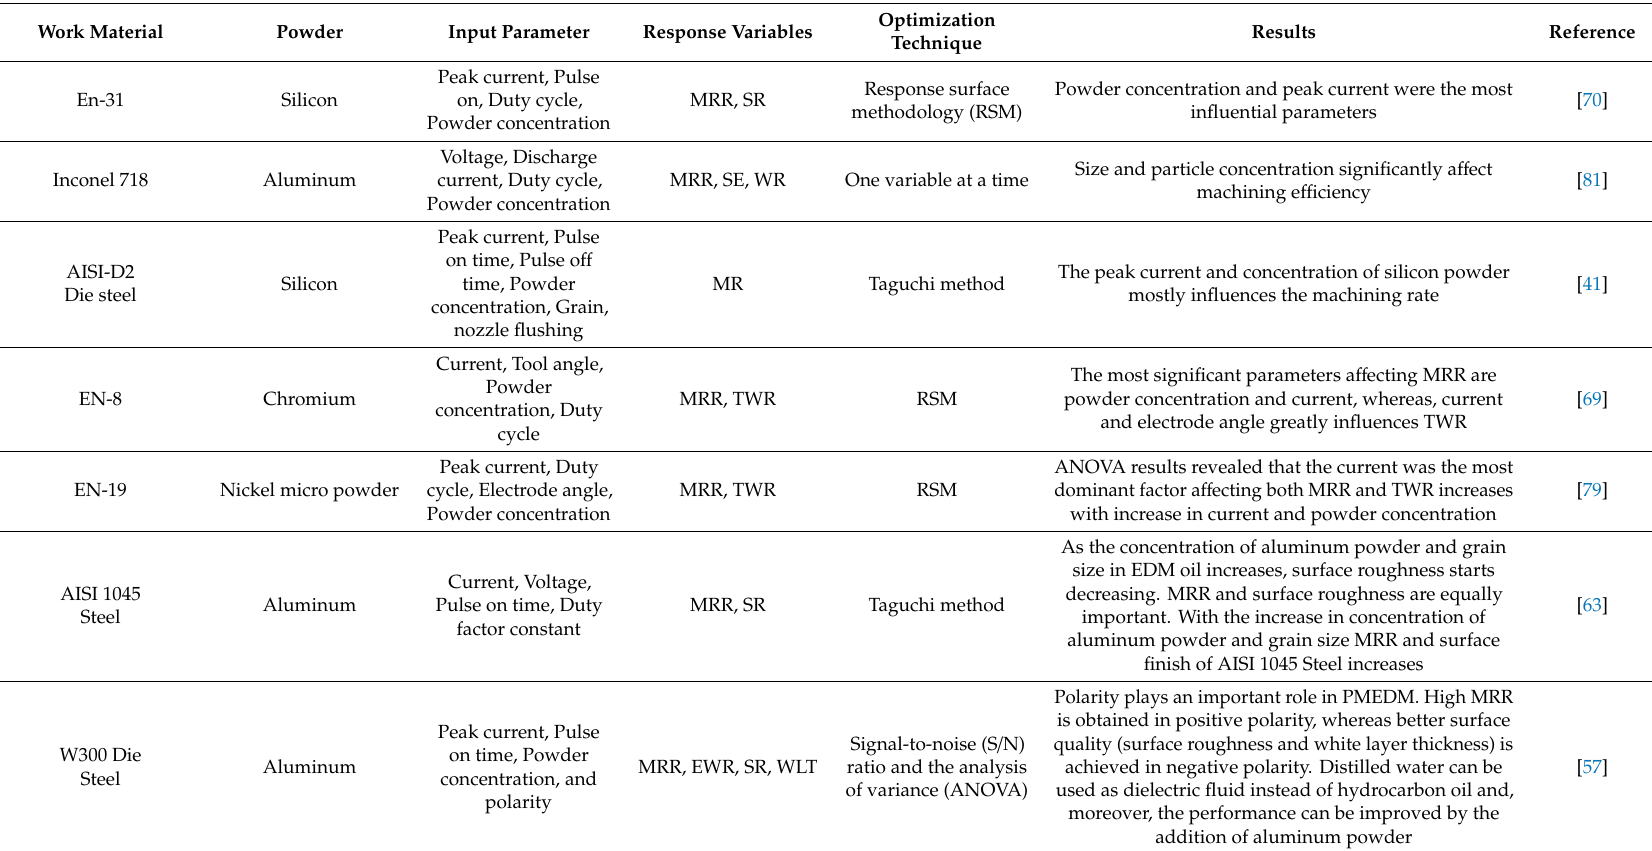
Table 3. Review on optimization of process